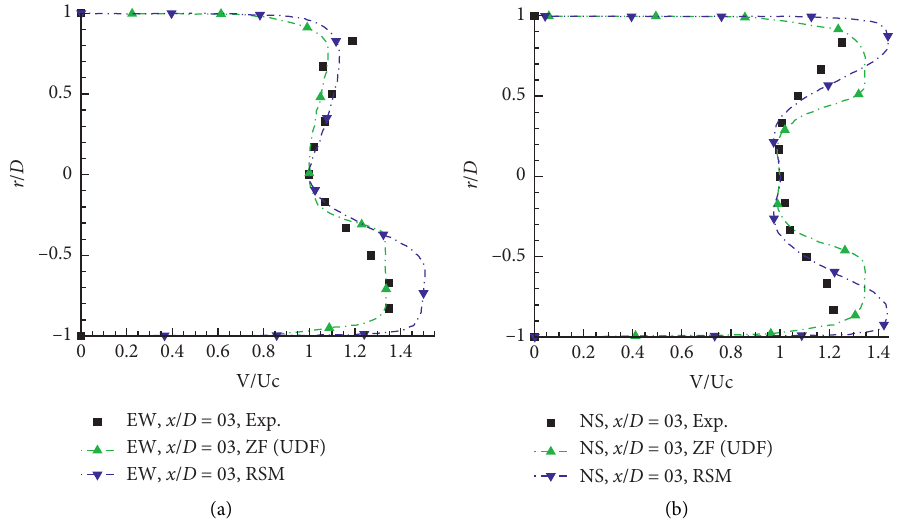
Figure 5: Normalized velocity profiles for different turbulence models at x / D � 3.